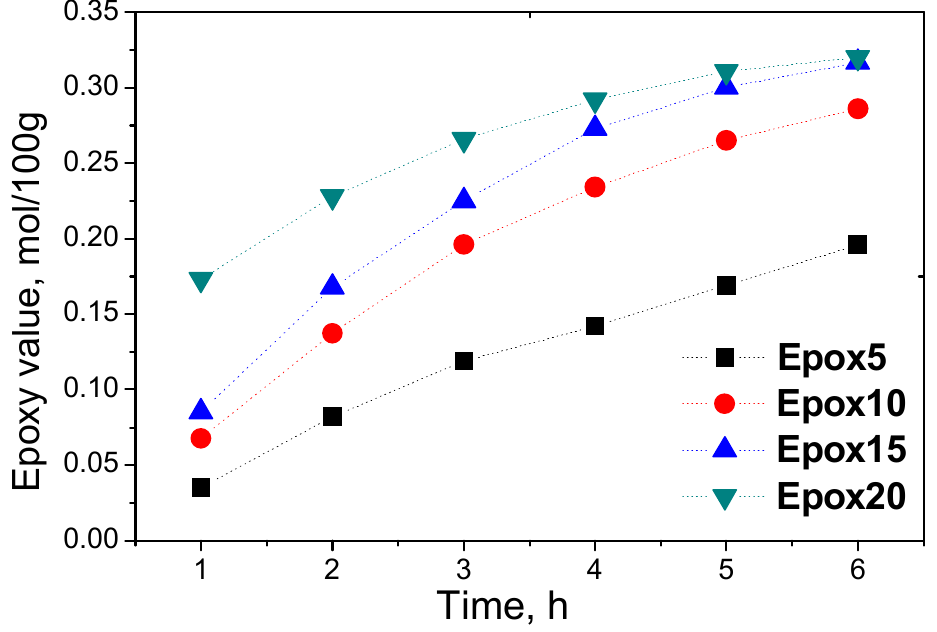
Figure 1. E ff ect of increasing catalyst concentration on epoxy value of epoxidized used cooking oil. The oxirane rings content increased monotononically with the reaction time for all reactions. As expected, the e ffi ciency of the reaction is greater when the catalyst concentration is higher. It was observed that after 6 h of the reaction the epoxy values of Epox15 and Epox20 are similar and it is not necessary to increase the catalyst concentration up to 20%. The increase in the intensity of the absorption band during the reaction, characteristic of epoxy groups depending on the catalyst concentration, is presented in Figure